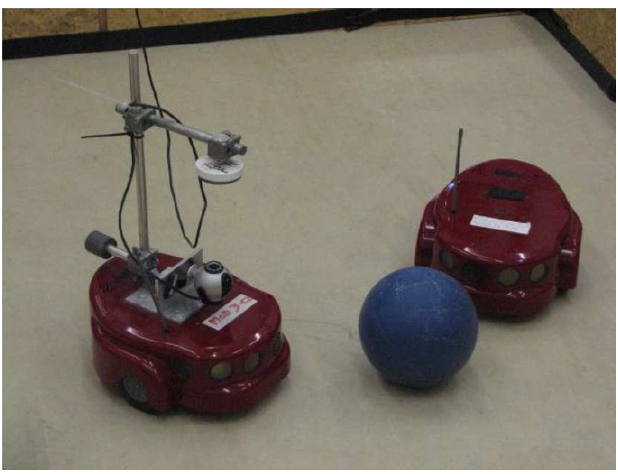
Figure 2. robo-CAMAL (left) in an experiment environment with ball and a fur- ther robot within a bounded